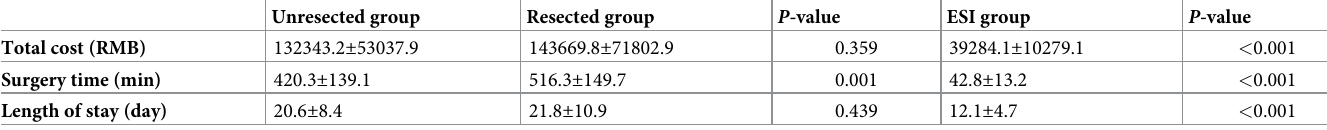
Table 1. Comparison of total cost, surgery time and hospital stay between resected group or endoscopic stent implantation (ESI) group with unresected